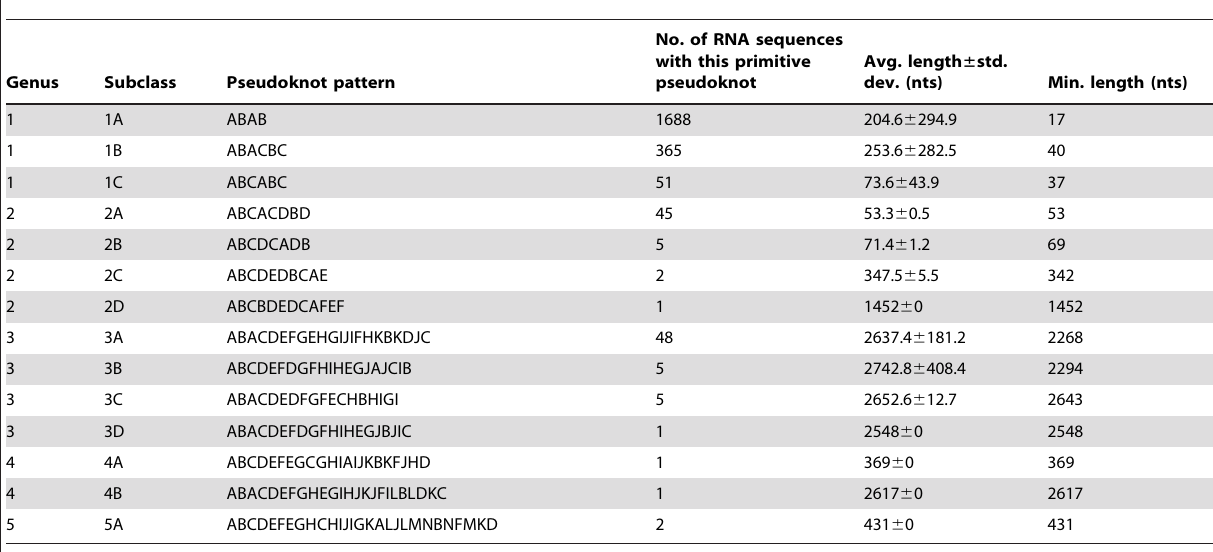
Table 3. Overall statistics of topologically classified primitive pseudoknots.